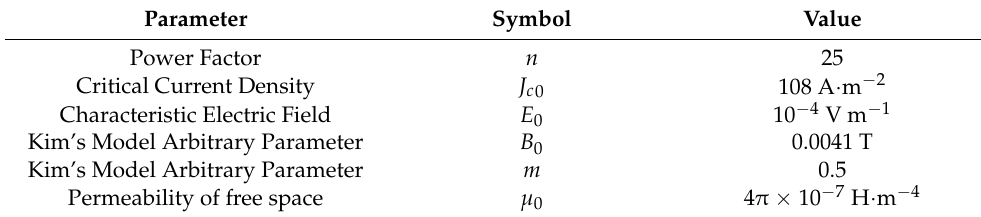
Table 1. Model Parameters.